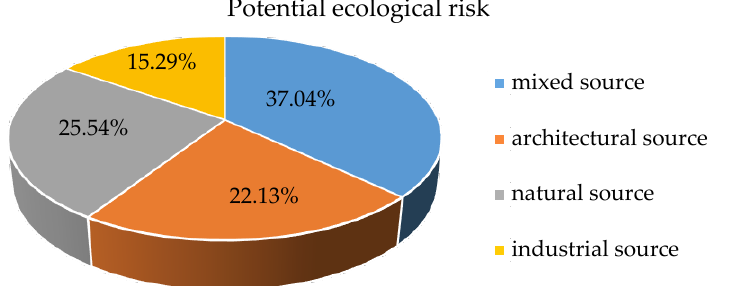
Figure 7. Proportion of potential ecological risk from different sources of HMs.